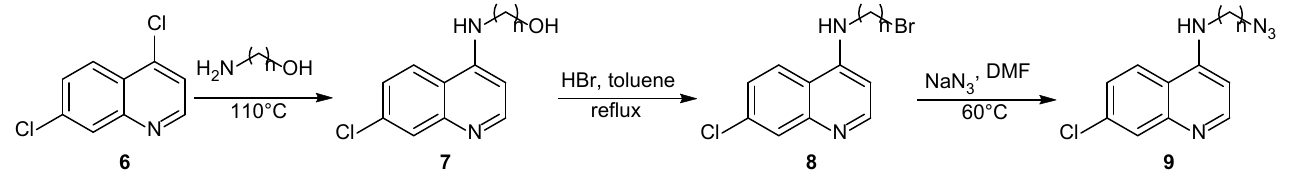
FIGURE 2 – Obtainment of the building block ( 9 ) from 4,7-dichloroquinoline employed on the